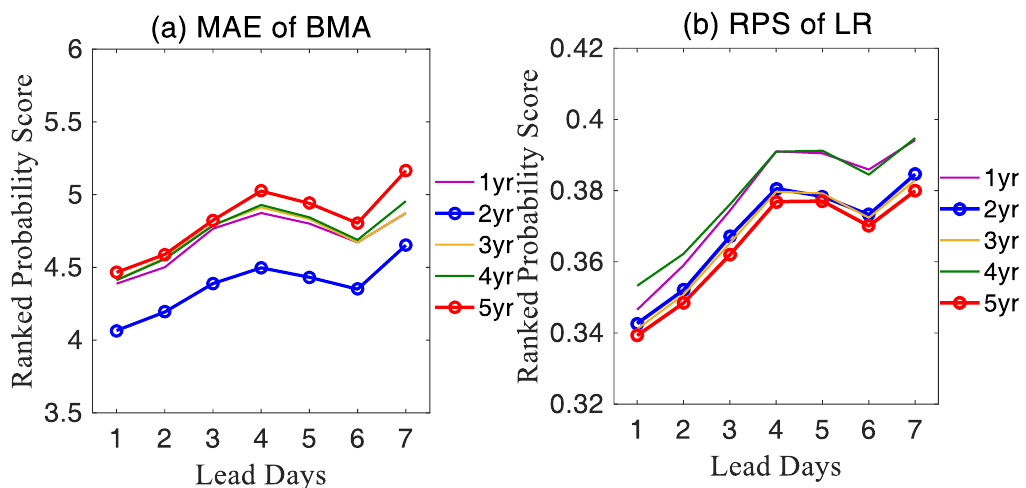
Figure 2. Comparison of training period lengths in the Wujiang River Basin: ( a ) The mean absolute error (MAE) of Bayesian model average (BMA) forecasts and ( b ) the ranked probability score (RPS) of the logistic recession (LR) forecasts (1 yr = 1-year training period lengths). Considering the results of the two sensitivity tests, 2 years and 5 years were selected as the optimal training periods for the BMA and LR models, respectively, and then the model parameters were calibrated for the forecast study.